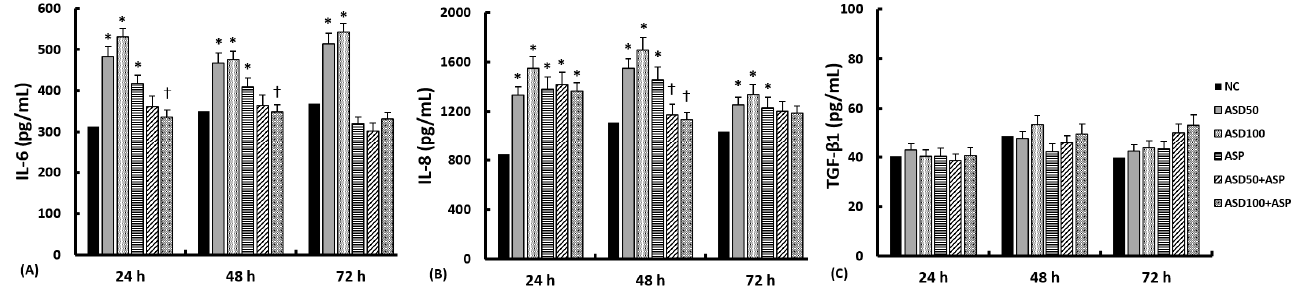
Figure 2. Effect of Aspergillus fumigatus (ASP) and Asian sand dust (ASD) on chemical mediator production in primary nasal epithelial cells. Doses of 50 μ g/mL ASD (ASD50) and 100 μ g/mL ASD (ASD100) enhanced interleukin (IL)-6 ( A ) and IL-8 ( B ) production at each time point. ASP also enhanced IL-8 at every time point and IL-6 at 24 h and 48 h. The coculture of ASP and ASD did not enhance IL-6 and IL-8 production. Transforming growth factor (TGF)- β 1 ( C ) production was not influenced by stimulation with ASP and/or ASD. NC: negative control, *: p < 0.05 compared to NC, k = 14.